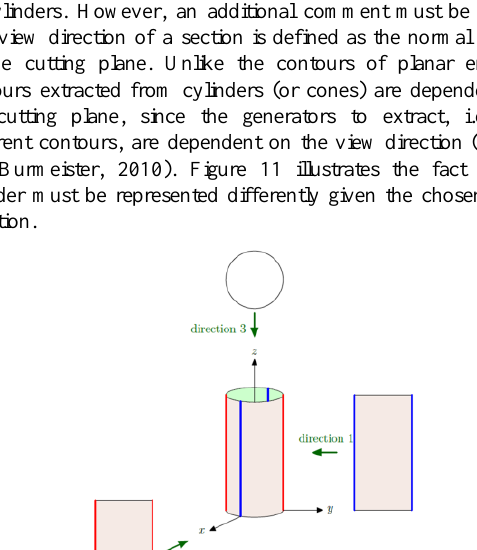
Figure 10. 3D cylindrical choir of Dugny rolled out as plane; point cloud (left); extracted contours, ds = 5 cm (right) At this point, the algorithm is able to extract the contour points of cylinders. However, an additional comment must be made.